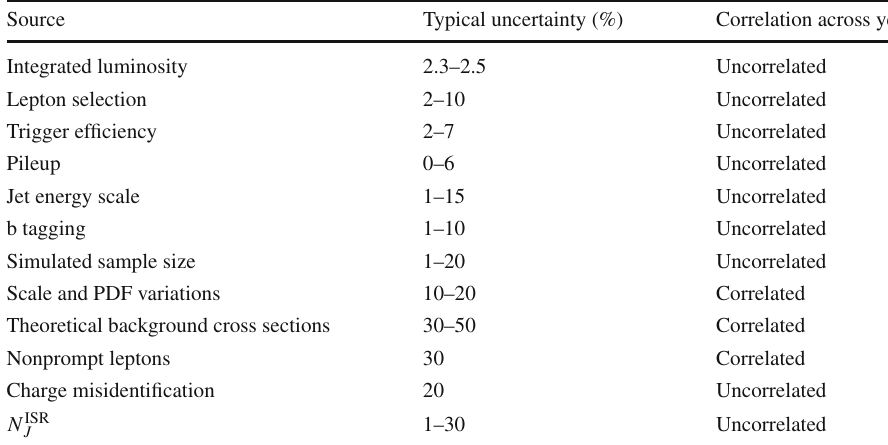
Table 8 Summary of